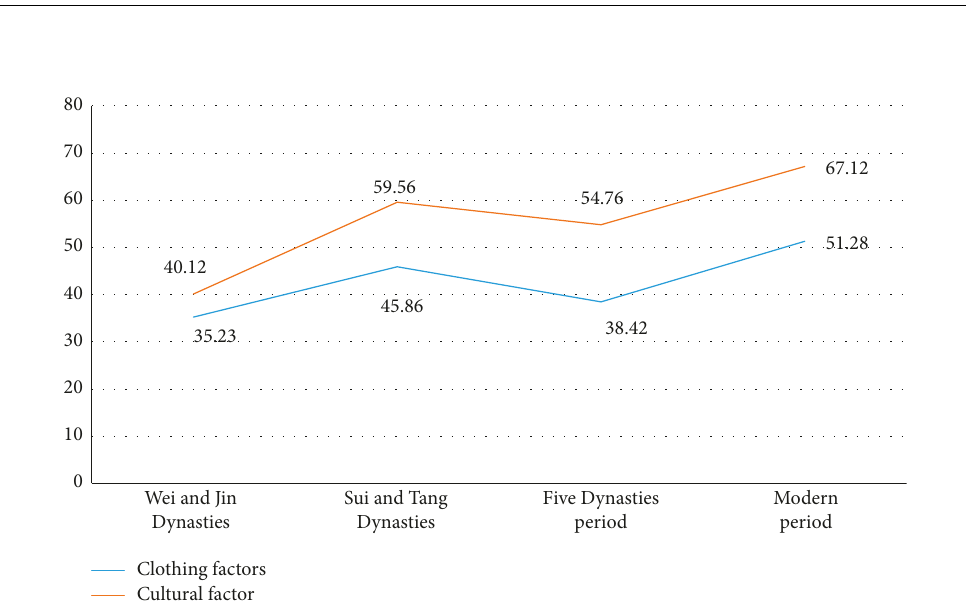
Figure 4: Visual analysis of the impact of clothing and culture in different periods.